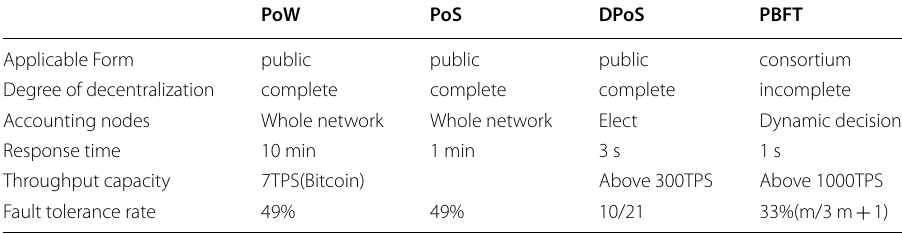
Table 1 Performance comparison of consensus